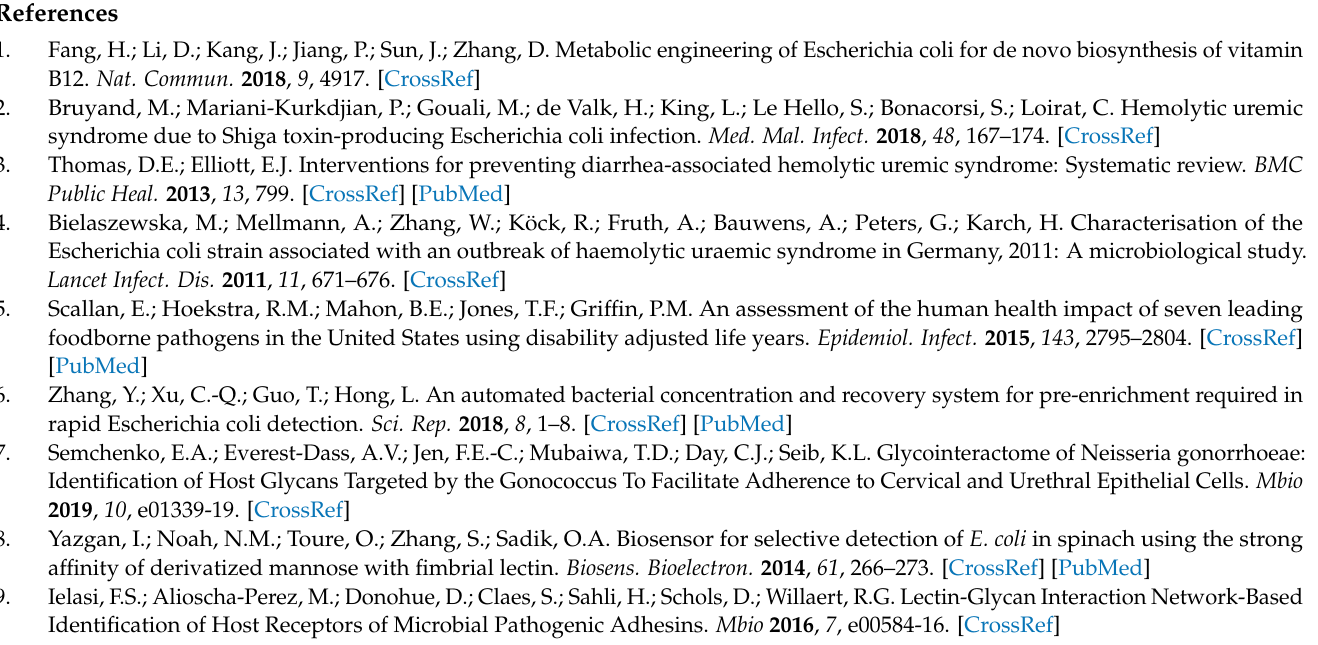
tion of MUA, (B) shows the addition of EDC/NHS, (C) shows the addition of the ligand, (D) shows the addition of glycine, and (E) shows the addition of 1 × 10 5 CFU/mL E. coli ; Figure S4: Individual mass changes for each modification step and detection of pathogen for 4-PBA ligand. (A) shows the addition of MUA, (B) shows the addition of EDC/NHS, (C) shows the addition of the ligand, (D) shows the addition of glycine, and (E) shows the addition of 1 × 10 6 CFU/mL E. coli ; Figure S5: Individual mass changes for each modification step and detection of pathogen for 6-AHPligand. (A) shows the addition of MUA, (B) shows the addition of EDC/NHS, (C) shows the addition of the ligand, (D) shows the addition of glycine, and (E) shows the addition of 1 × 10 3 CFU/mL E. coli ; Figure S6: Individual mass changes for each modification step and detection of pathogen for 6-AHP ligand. (A) shows the addition of MUA, (B) shows the addition of EDC/NHS, (C) shows the addition of the ligand, (D) shows the addition of glycine, and (E) shows the addition of 1 × 10 4 CFU/mL E. coli ; Figure S7: Individual mass changes for each modification step and detection of pathogen for 6-AHP (A) shows the addition of MUA, (B) shows the addition of EDC/NHS, (C) shows the addition of the ligand, (D) shows the addition of glycine, and (E) shows the addition of 1 × 10 5 CFU/mL E. coli ; Figure S8: Individual mass changes for each modification step and detection of pathogen for 6-AHP ligand. (A) shows the addition of MUA, (B) shows the addition of EDC/NHS, (C) shows the addition of the ligand, (D) shows the addition of glycine, and (E) shows the addition of 1 × 10 6 CFU/mL E. coli